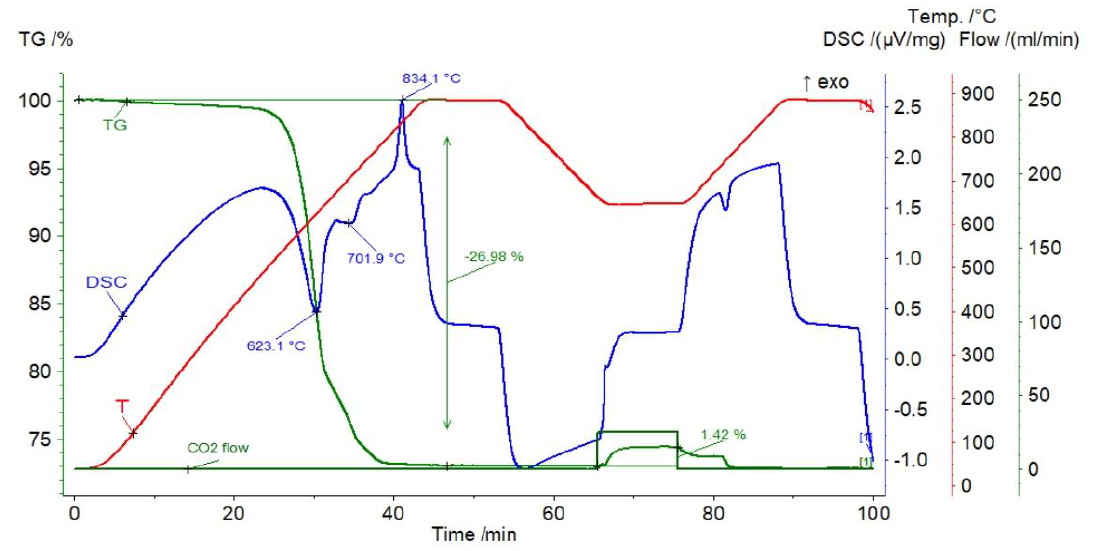
Figure 12. TGA and DSC curves for serpentinite.